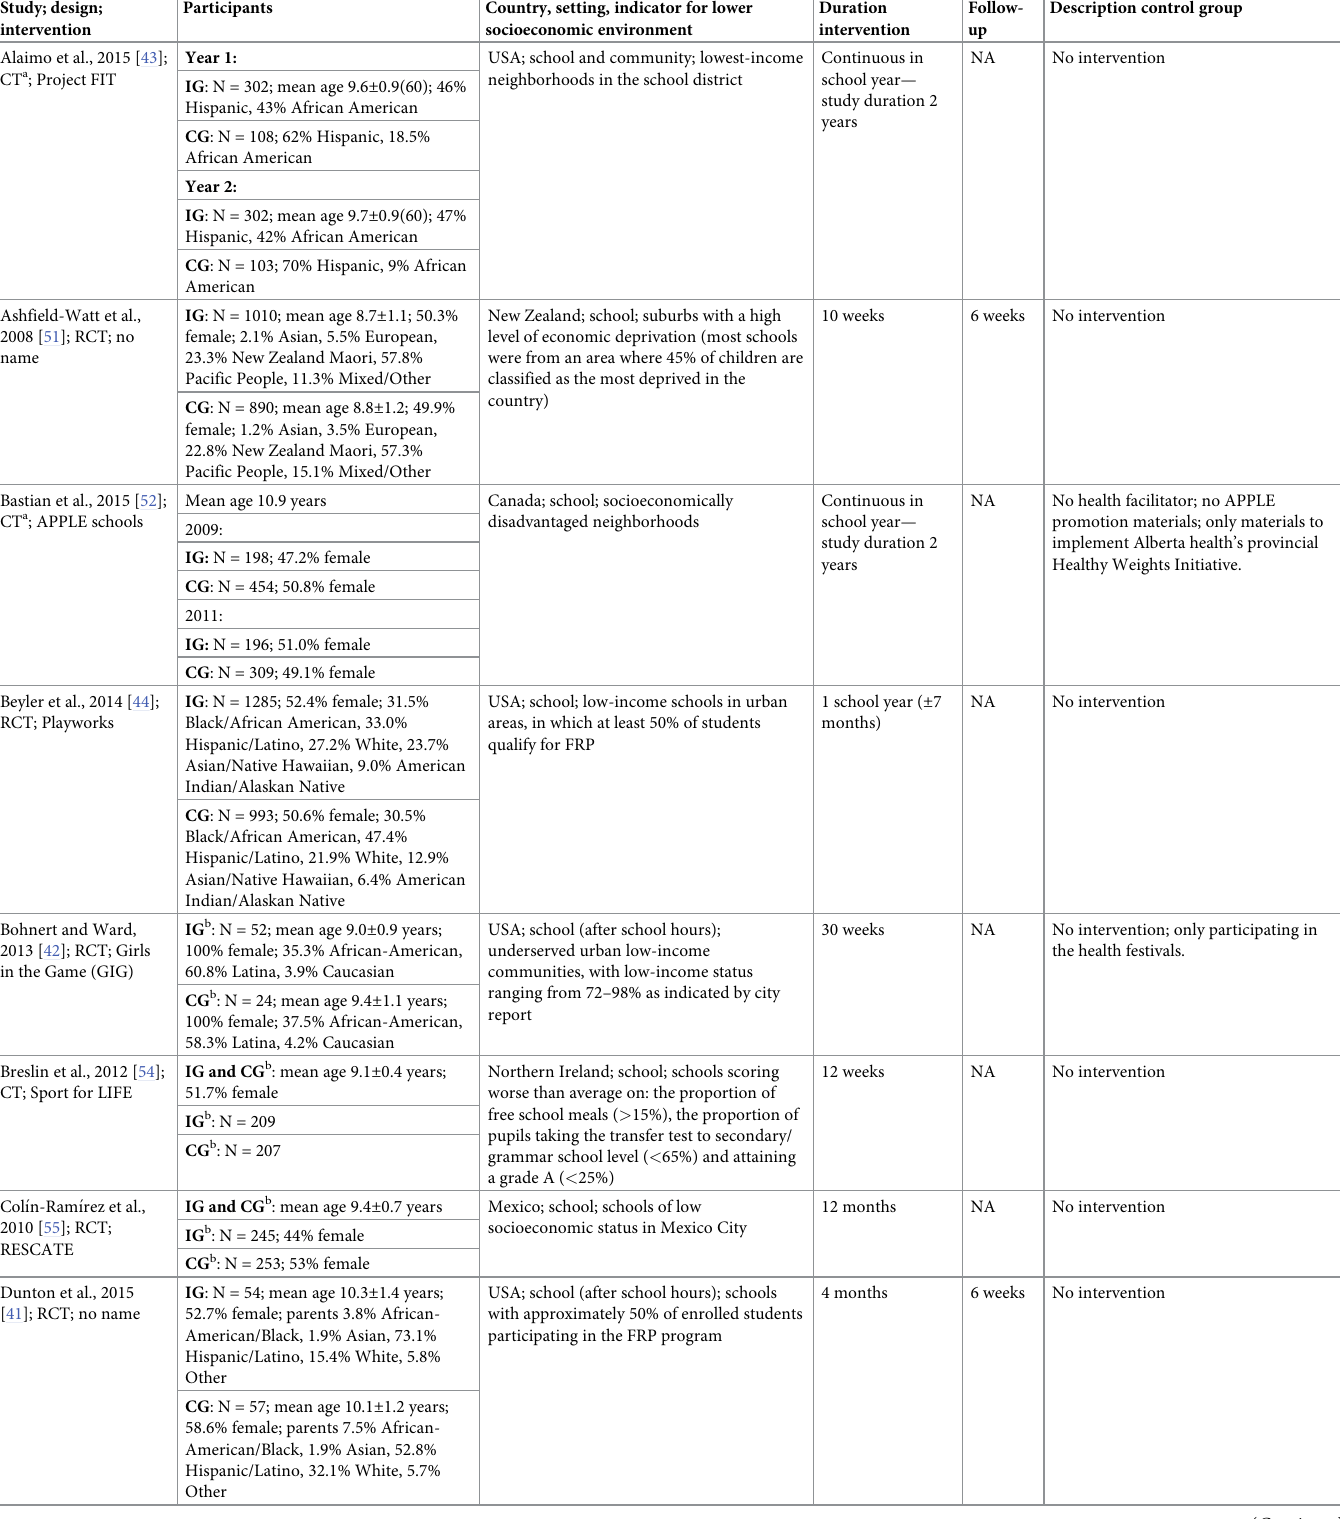
Table 1. Study and intervention characteristics of the included